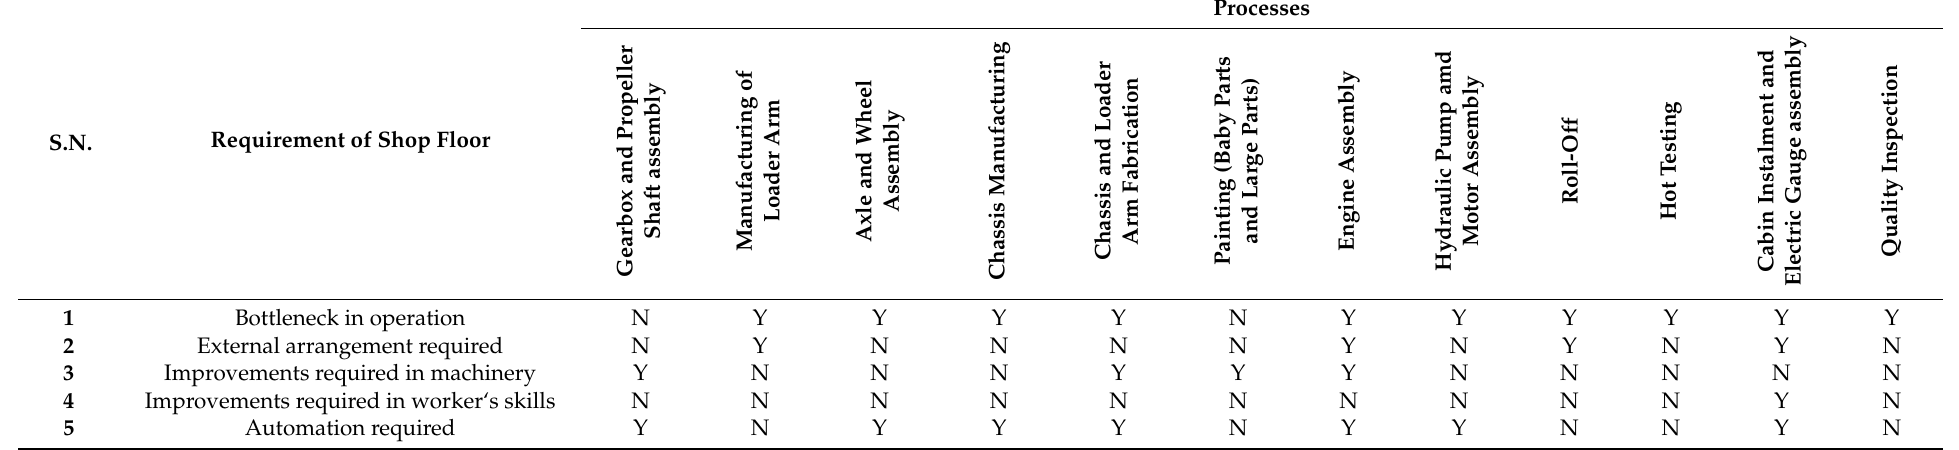
Table 10. Implemented factors according processes in industry